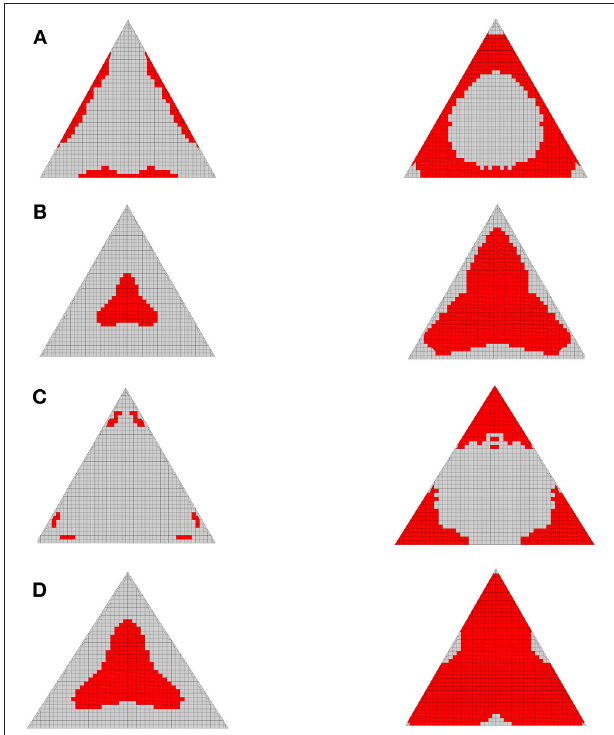
FIGURE 15 | Cracking propagation of a triangular slab on the: (A) top-clamped, (B) bottom-clamped, (C) top-simple supported, and (D) bottom-simple